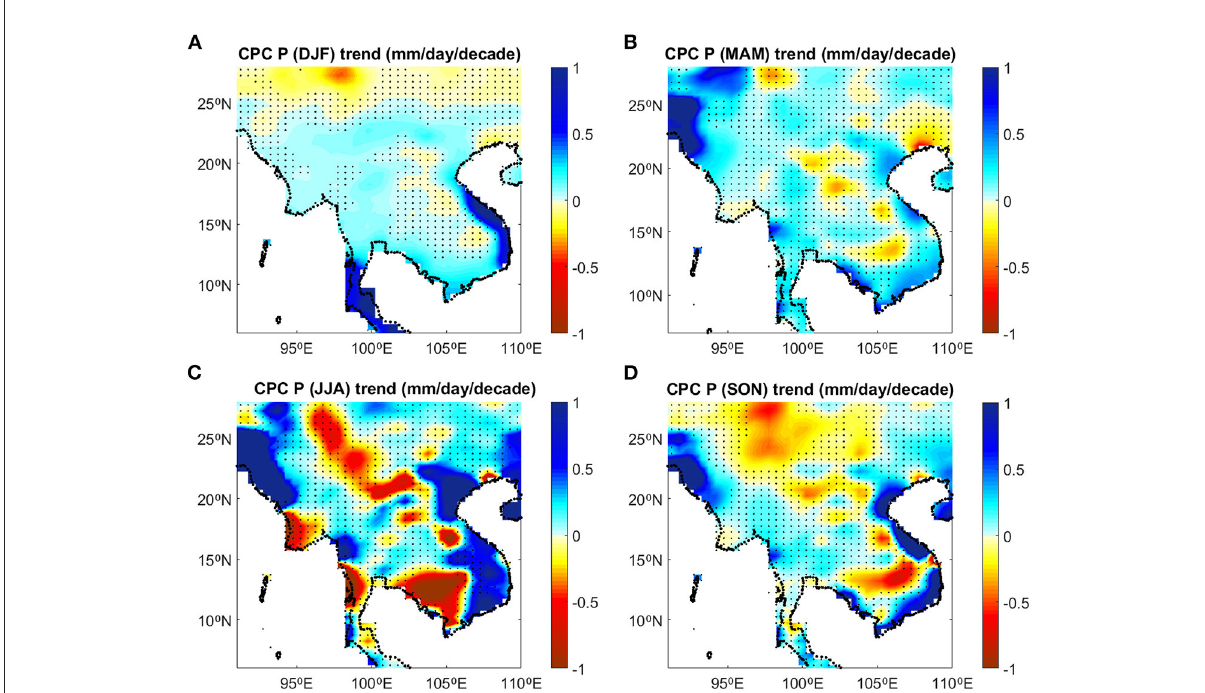
FIGURE4 Seasonal precipitation trends (mm/day/decade) over 1979–2018 from the Global Unified Gauge-Based Analysis of Daily Precipitation–Climate Prediction Center (CPC) dataset: (A) Winter (Dec–Feb); (B) Spring (Mar–May); (C) Summer (Jun–Aug); (D) Autumn (Sep–Nov). Regions where the linear trend is not significant at the 95% confidence interval are stippled.